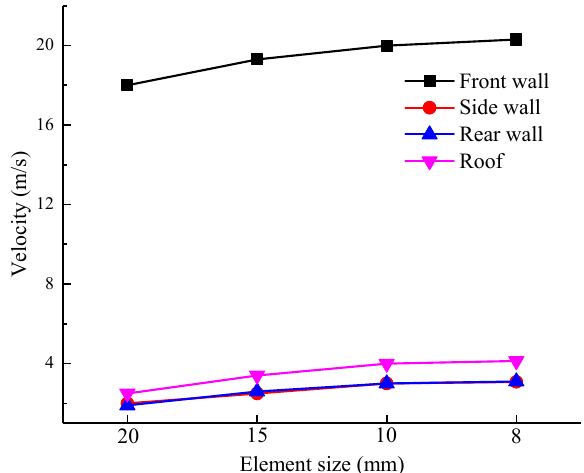
Figure 13. The effect of mesh size.